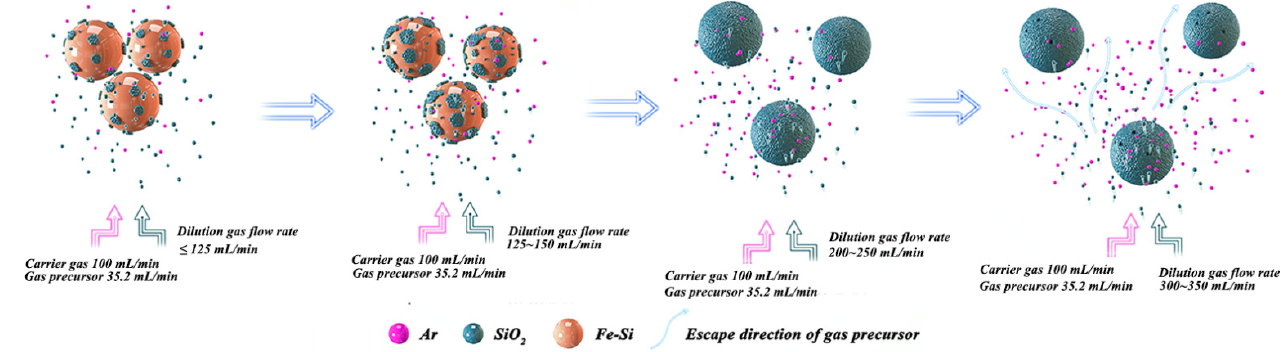
Figure 4. Schematic of a possible influential mechanism of the Ar-carrier gas flow rate on the microscopic appearances of Fe–Si/SiO 2 composite particles.